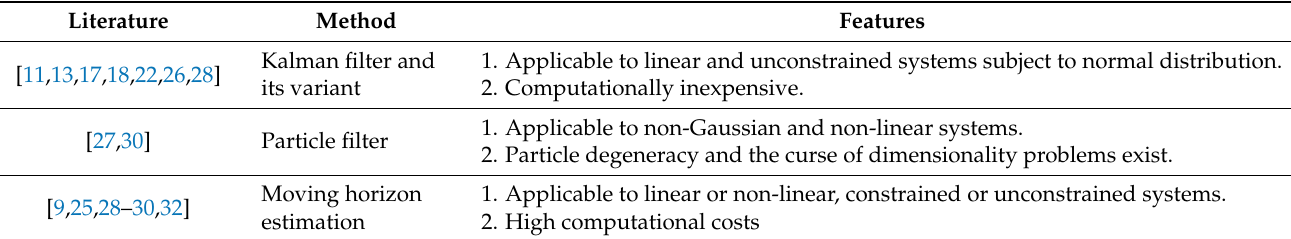
Table 2. Summary of common estimation algorithms.